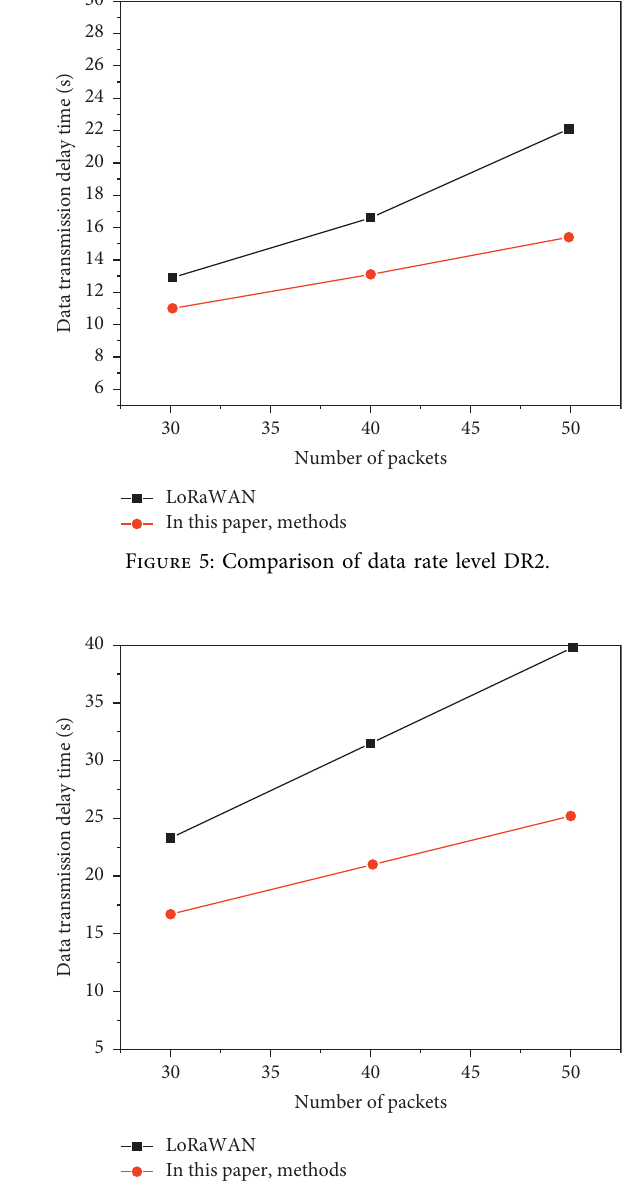
Figure 6: Comparison of data rate level